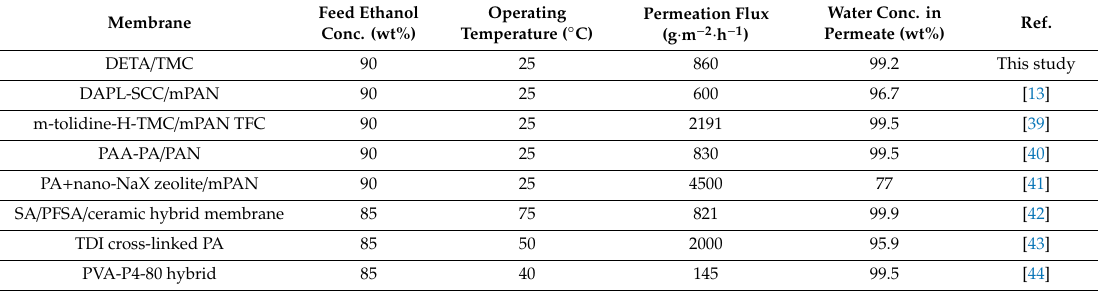
Figure 10. TFC isopentane membrane performance at different feed alcohol solution. Feed = 90 wt% aqueous alcohol solution at 25 ◦ C. Downstream pressure = 13 mmHg. Table 4. A comparison of membrane performance in our work with other reported literature.